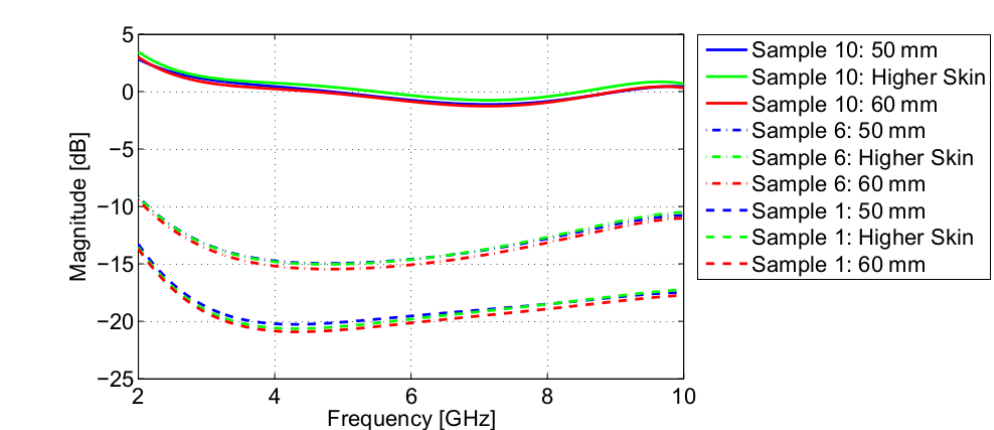
Figure 7. Antenna response variation due to different skin properties and different separation distances.